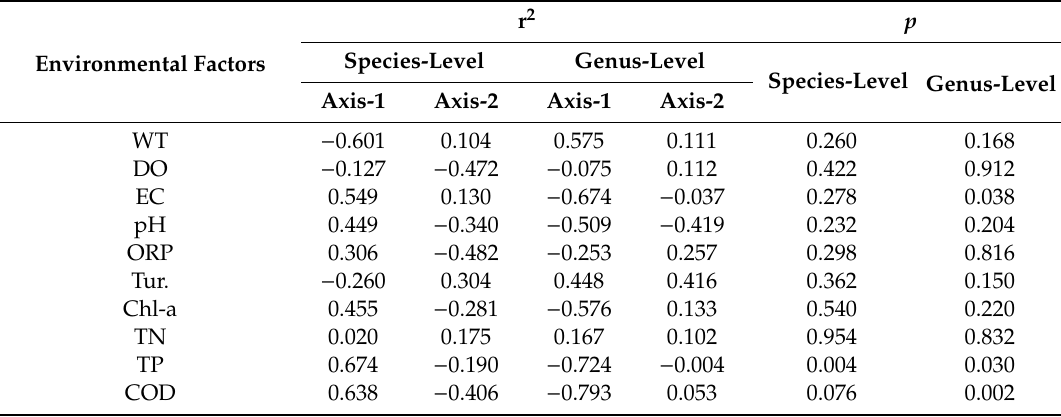
Table 3. Summary statistics of Redundancy analysis at species level and genus